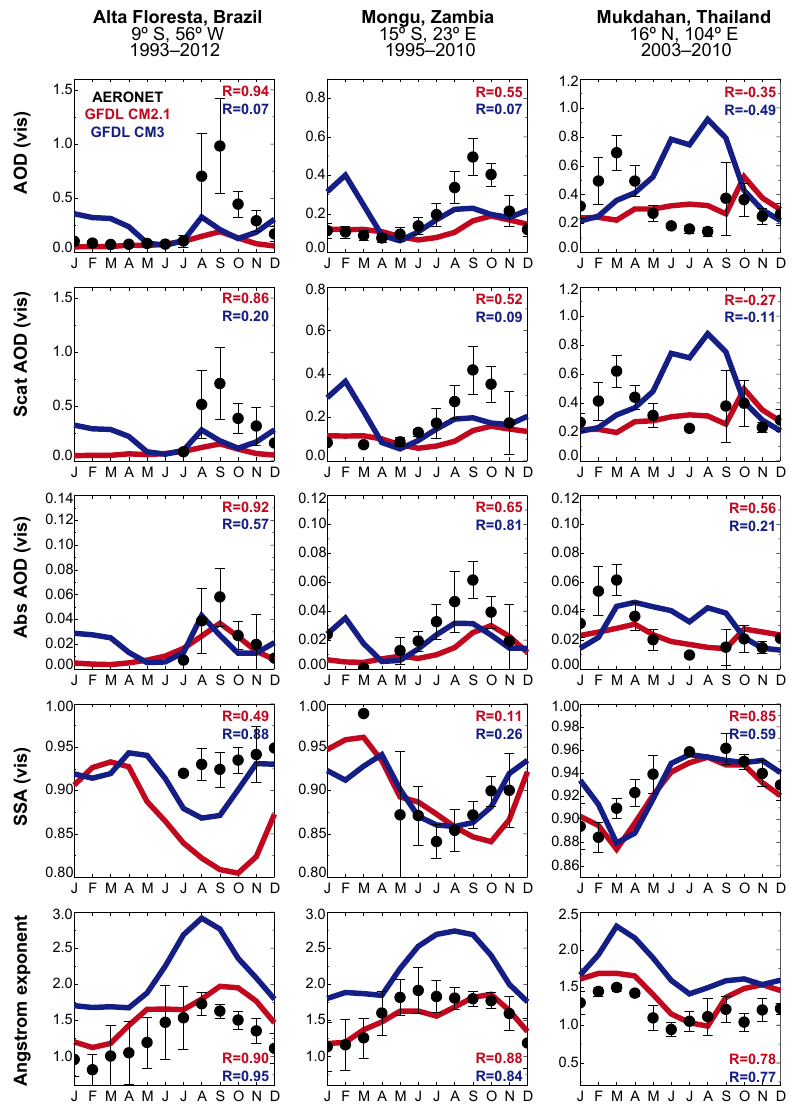
Figure 8. Optical properties from AERONET and the models for biomass burning region sites. AERONET optical properties (circles) measured at 440nm but derived at 550nm (see text for details) and model optical properties (CM2.1: red lines, CM3: blue lines) calculated at 550nm. The error bars represent year-to-year variability of AERONET